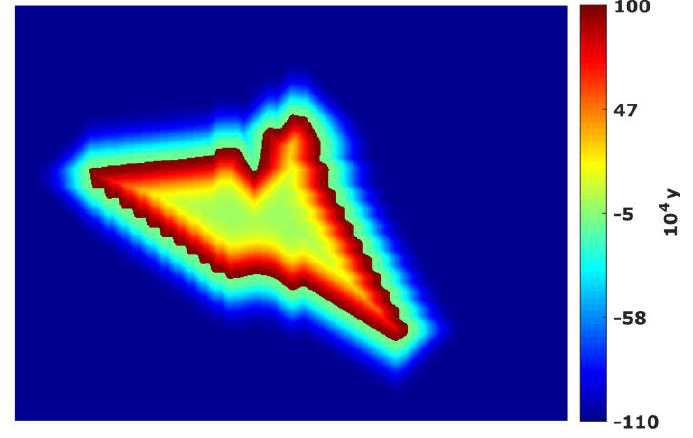
Figure 11. Visual representation of the matrix 𝑀̿ 1 created from the yellow contour of Figure 10. In the scale, y refers to the function graphed in Figure 4, which is here multiplied by a factor of 10 4 for the sake of clarity.